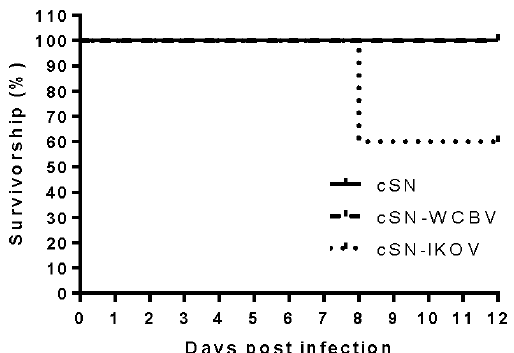
Figure 3. Survival curve of mice challenged peripherally. Each mouse was challenged with 1000 ffu/50 μL of either cSN, cSN-WCBV-G, or cSN-IKOV-G via the foot pad. ( n = 5/virus). Mice were observed for 28 days. Results are shown up to day 12 after which no further mice developed clinical disease.